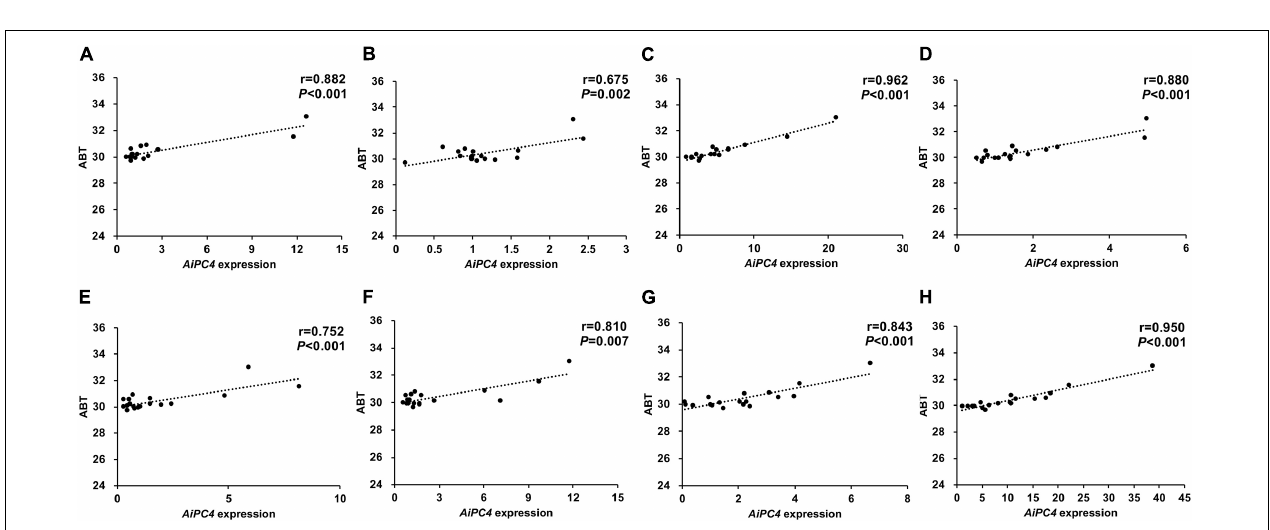
FIGURE 6 | Correlation analysis between AiPC4 expression levels in tissues and ABT values of bay scallops [ (A) mantle; (B) gill; (C) testis; (D) ovary; (E) kidney; (F) striated muscle; (G) hepatopancreas; (H)